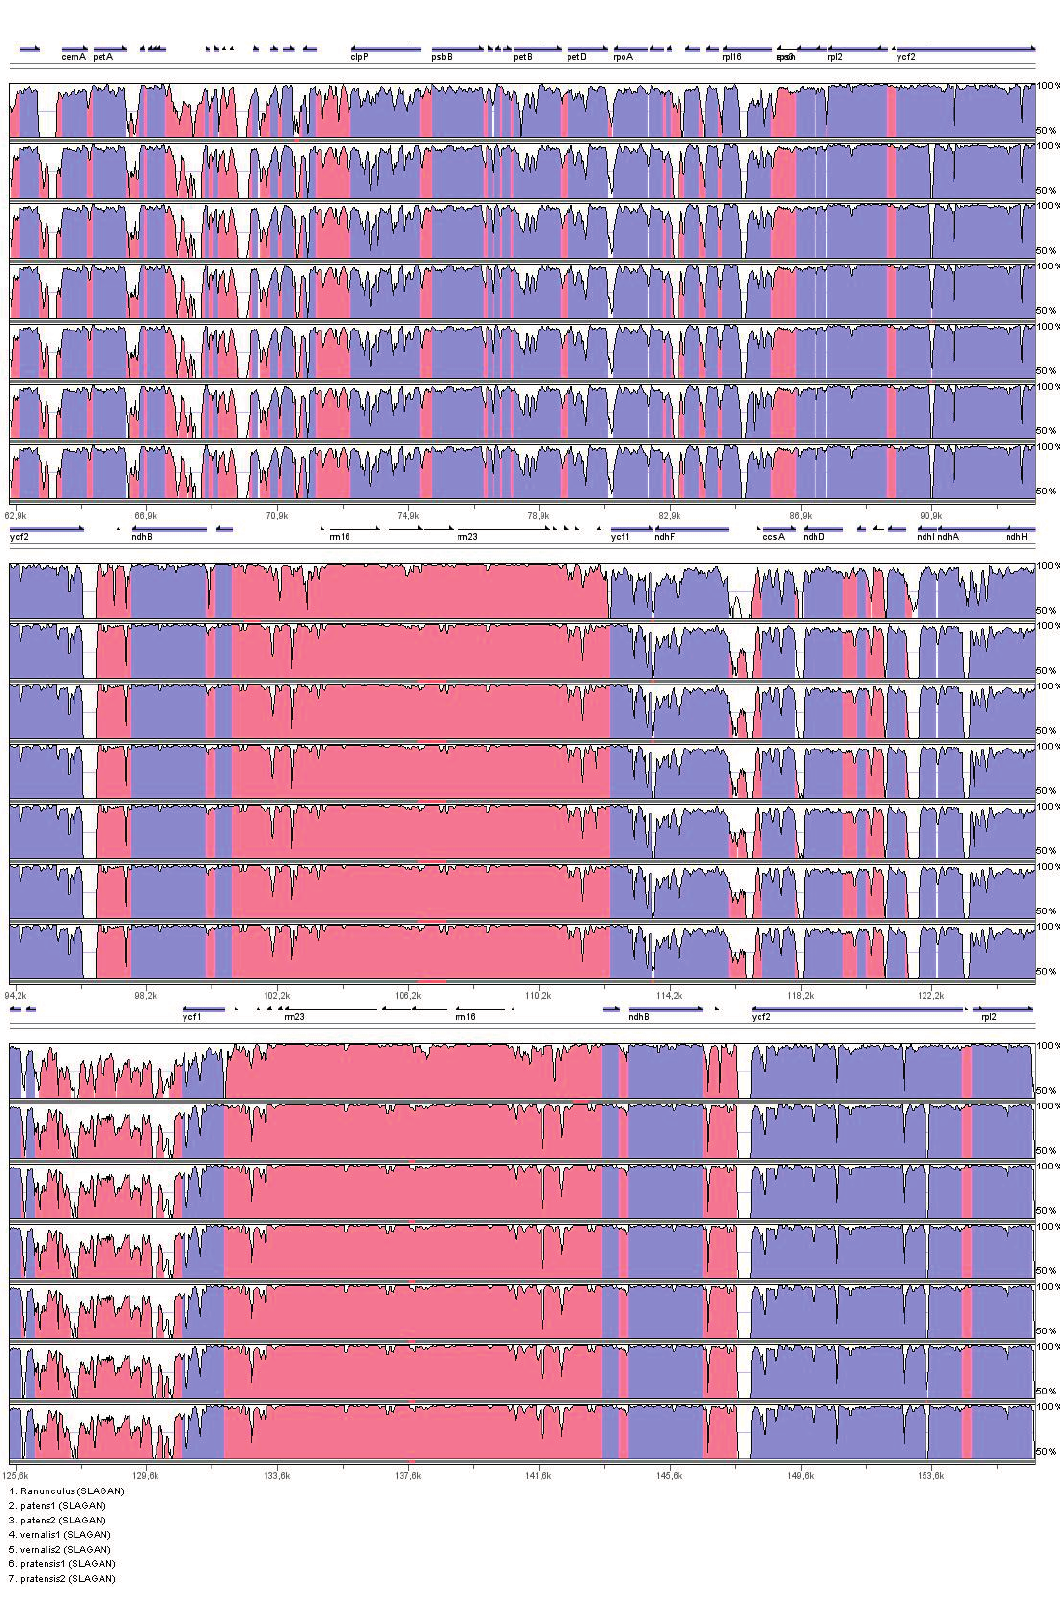
Figure 3. Alignment of eight plastid genome sequences in plants of the family Ranunculaceae. VISTA-based identity plots show sequence identity between six sequenced plastid genomes and the previously-identified sequences in Ranunculus macranthus and Aconitum barbatum as a reference. The red and purple parts visualize the conserved non-coding and coding regions